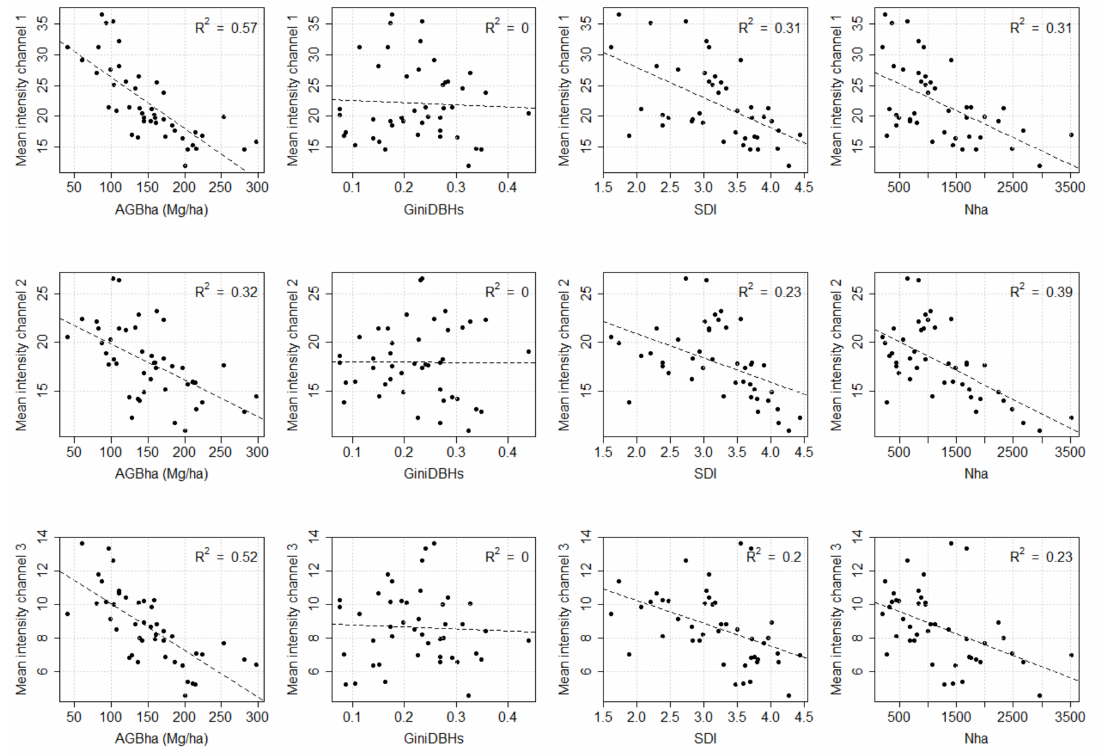
Figure 3. Scatterplots of the response variables and the mean intensity of each Optech Titan channel for each